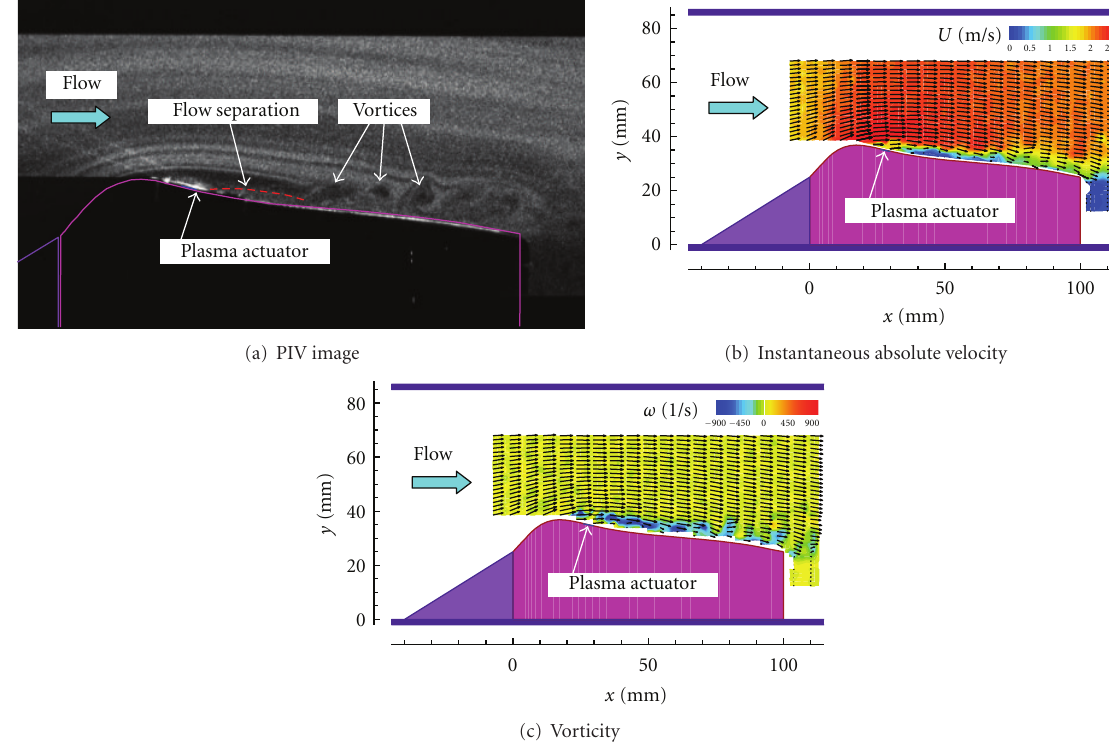
Figure 6: PIV measurements (flow control, V AC = ± 2.8